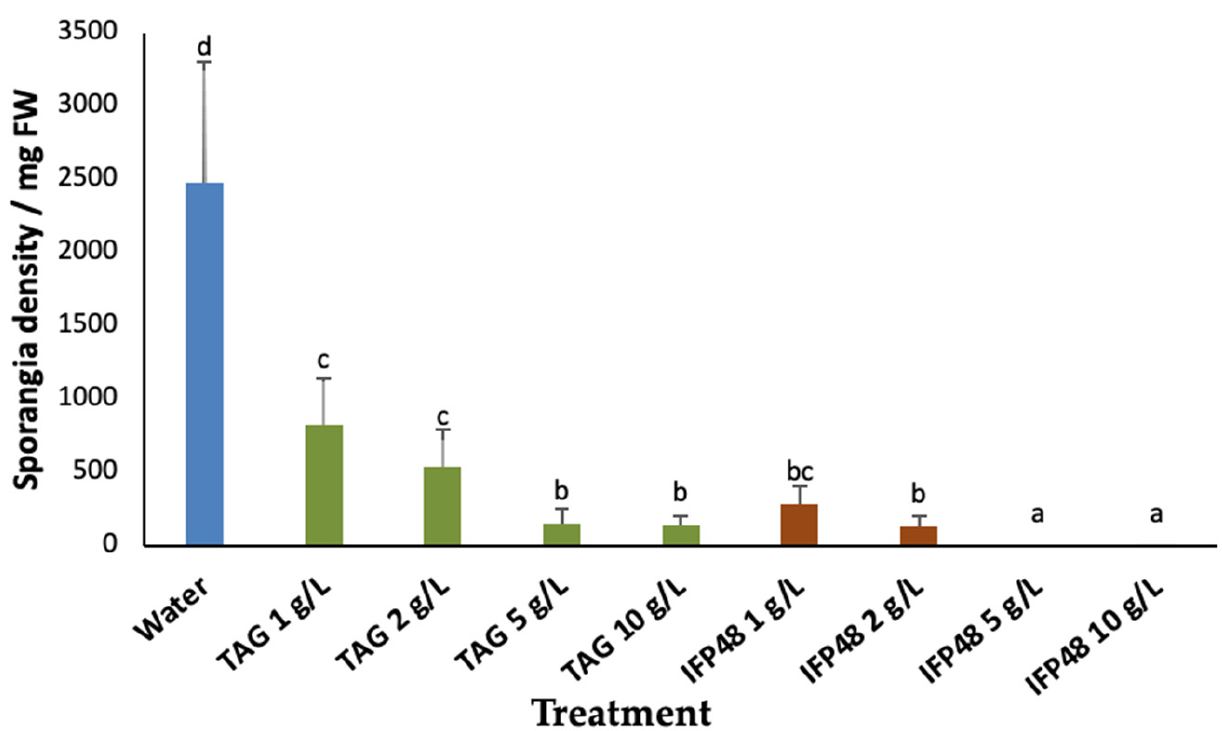
Figure 4. Direct effect of D-tagatose-based product on Plasmopara viticola . Detached leaves of in vitro plantlets were sprayed with 1, 2, 5, and 10 g/L D-tagatose-based formulated product (IFP48) or pure D-tagatose (TAG). As control, leaves were treated with water. Leaf inoculation was carried out at 2 h post treatment. Plasmopara viticola sporangia were quantified at eight days post-inoculation. Data are means ± SD from eight plants with five leaves per plant and three independent experiments. Different letters indicate significant differences according to the one-way ANOVA Welch’s test with Student’s t -test ( p ≤ 0.05).